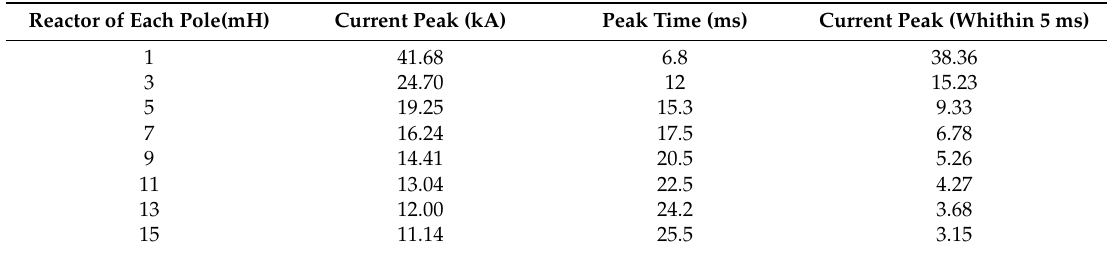
Table 8. Discharge current I 4 under different current limiting reactor of DC transformer. Reactor of Each Pole(mH)